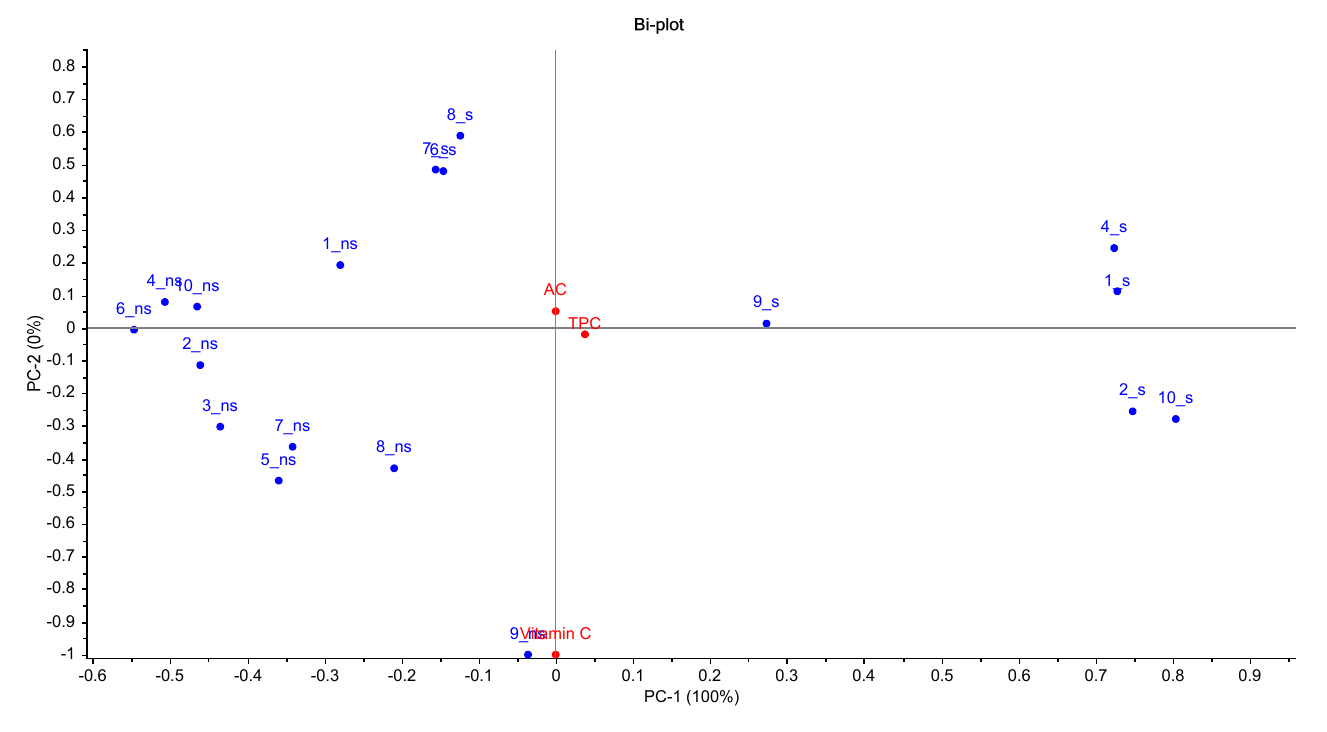
Figure 3. PCA Bi-plot for the sterilized (_s) and unsterilized (_ns) apple purees based on antioxidant capacity (AC), total phenolic compounds (TPC), and vitamin C. Numbers 1–10 represent the apple variety used in order to obtain the puree: 1—Champion, 2—Elstar, 3—Baujade, 4—Grimmes Golden, 5—Granny Smith, 6—P ă tul, 7—Reinette Harbert, 8—Juliana, 9—Domnesc, 10—Parmen